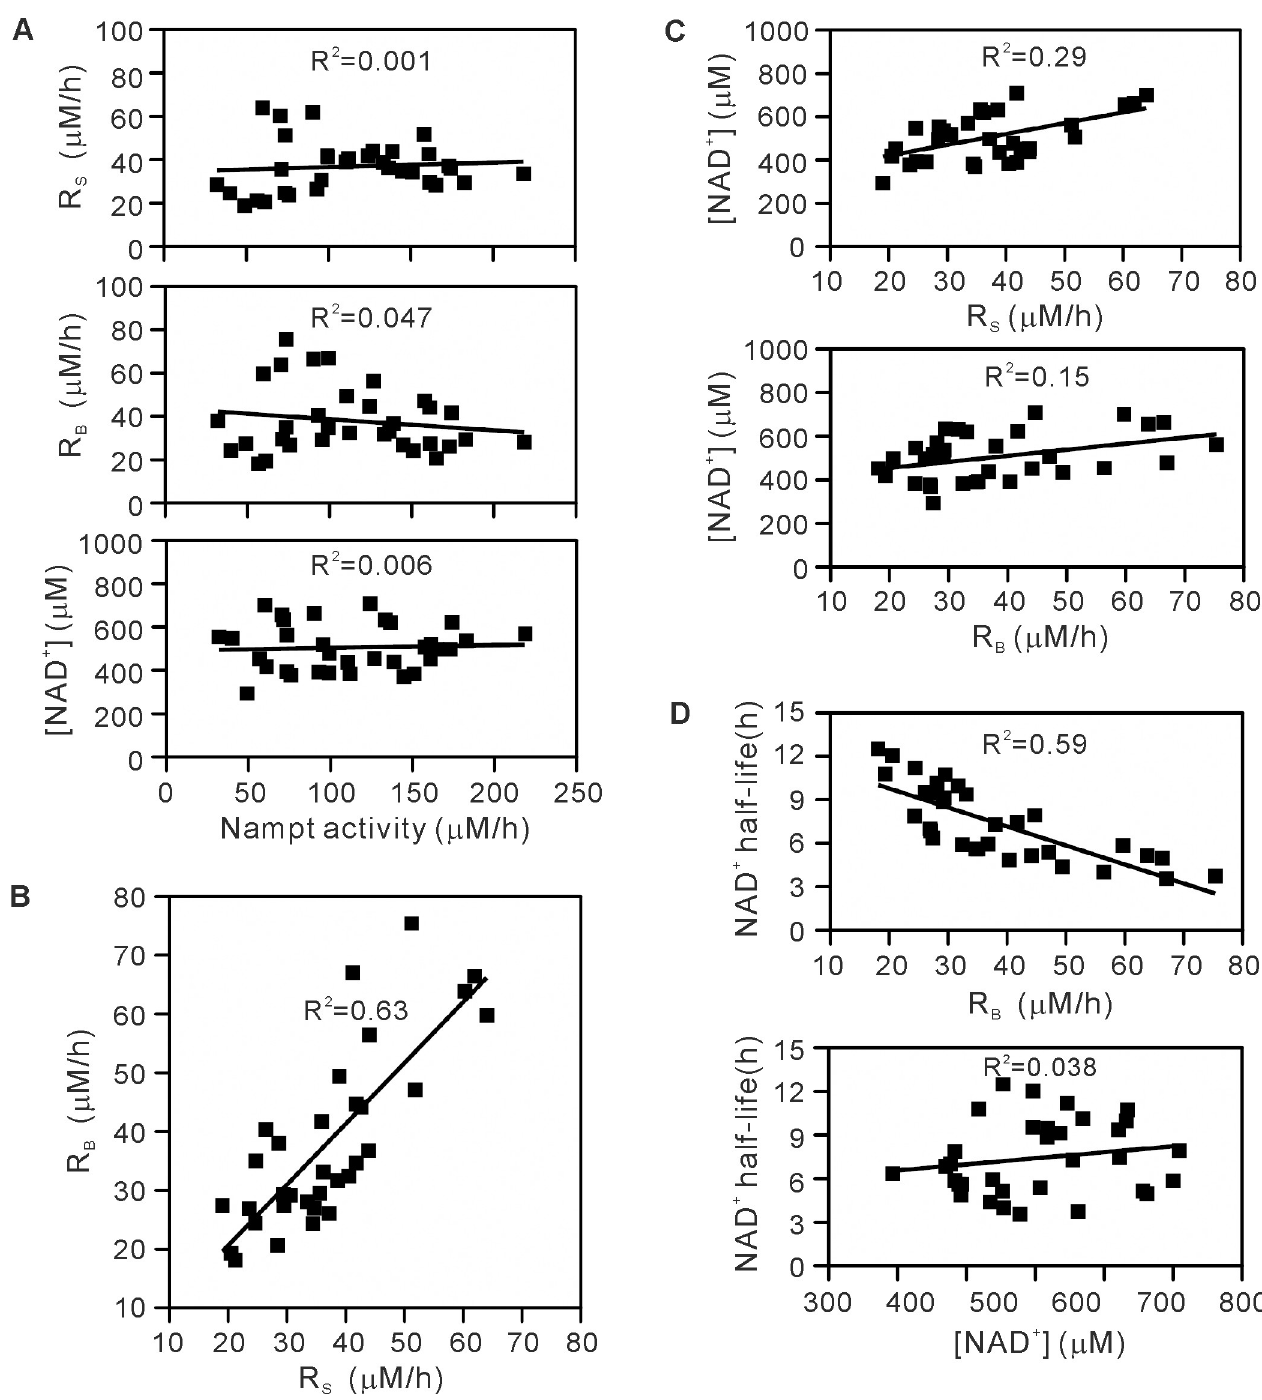
Fig 5. Relationship among total Nampt activity, R S , R B , cellular NAD + concentration, and calculated NAD + half-life. Data in Fig 4 were re-plotted. (A) Relation of R S , R B , and the NAD + concentration to total Nampt activity. (B) Relation between R S and R B . (C) Relation of the NAD + concentration to R S or R B . (D) Relation of NAD + half-life to R B or the NAD + concentration. Determination coefficience (R 2 ) is also indicated.